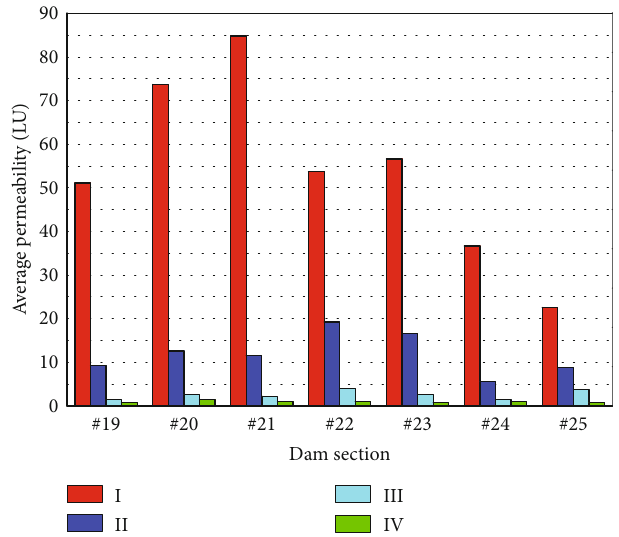
Figure 20: #19 ~ #25 dam section consolidation grouting of hole: average